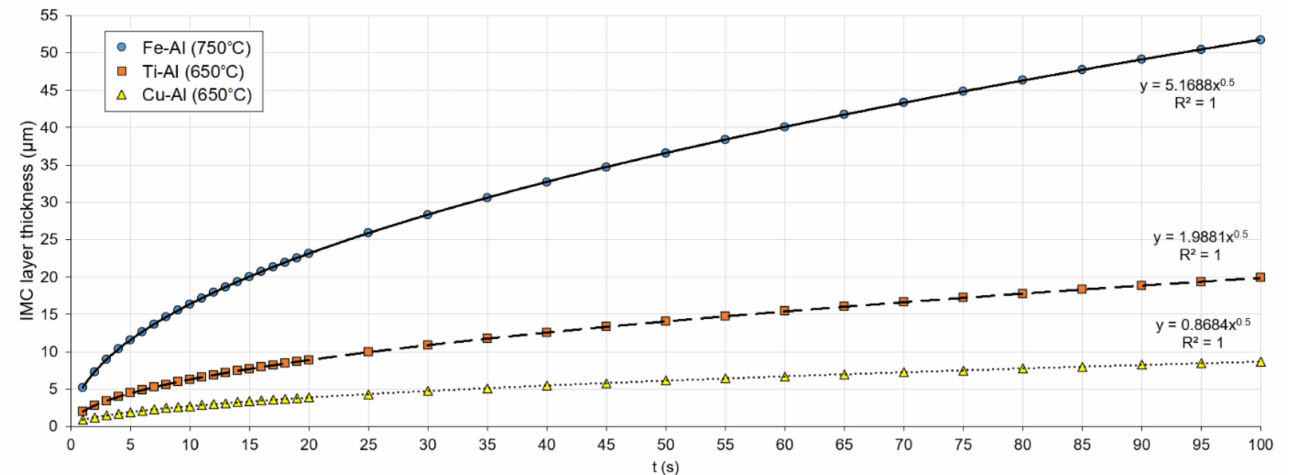
Figure 2. Calculated growth of IMC layer according to Equations (1) and